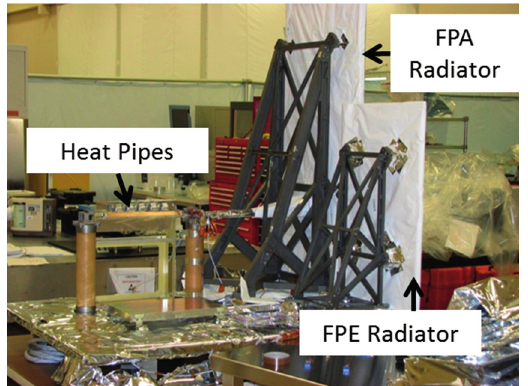
Figure 10. The OLI radiators and heat pipes prior to installation. The white blankets provide insulation to the back of the